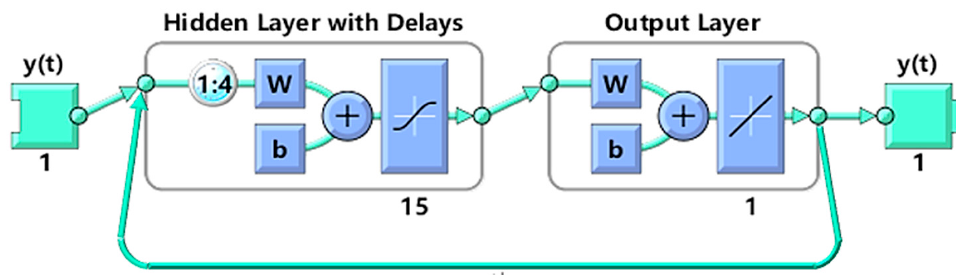
Figure 1. Structure of NAR model.